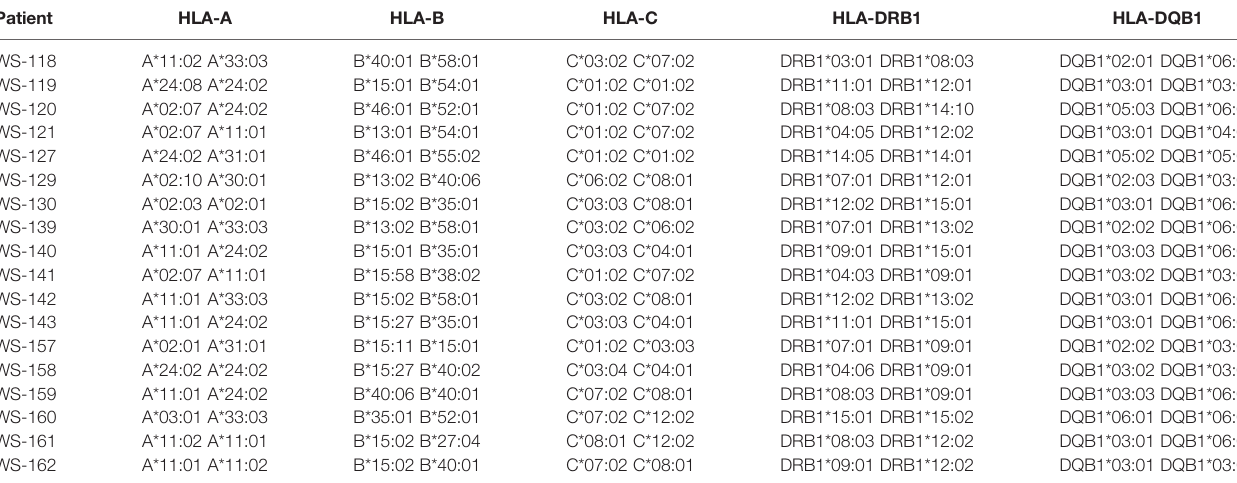
TABLE 3 | HLA phenotypes of the 18 Mtb patients. Patient HLA-A HLA-B HLA-C WS-118